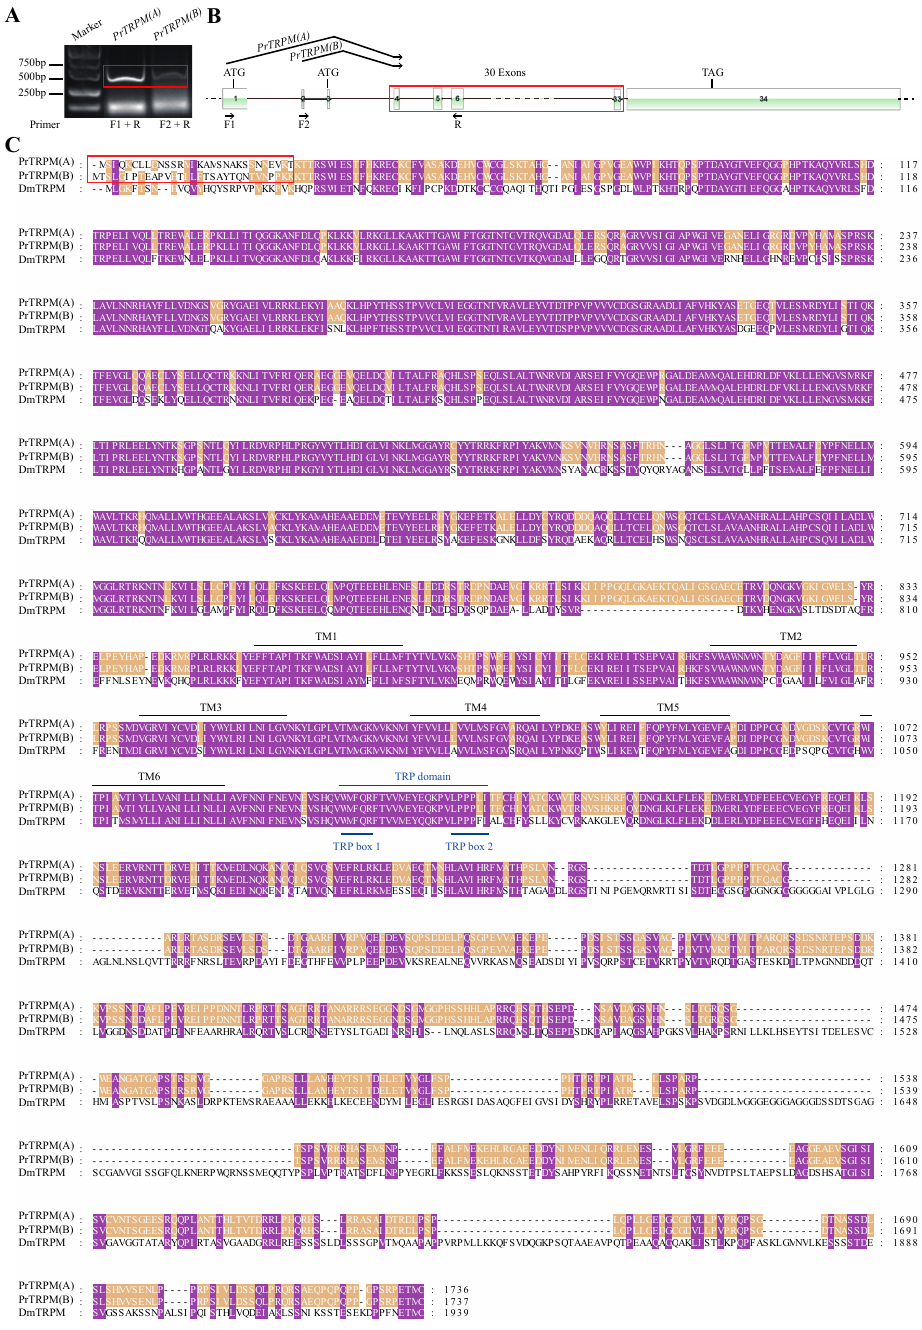
Figure 4. Detection and amino acid sequence alignment of the two PrPRPM splice forms. ( A ) Two molecular isoforms of PrTRPM mRNAs identified by PCR. The bands of PrTRPM mRNAs were indicated with open red box, and the bands below it were primer dimers or none-specific bands. ( B ) Two-dimensional gene structure map of PrTRPM . The boxes represented the exons of PrTRPM , the black solid lines connecting the boxes represented the introns and the black dotted lines on both sides represent other genome sequences. ( C ) Multiple sequence alignment deduced for PrTRPM(A), PrTRPM(B) and DmTRPM. The red box indicates the different amino acid residues of the two isoforms. TRP boxes and TRP domain were indicated with blue lines. Ankyrin repeats were indicated with dotted lines and marked as ANK1–2. Transmembrane regions were indicated with solid lines and marked as TM1–6. The protein sequences used for multiple sequence alignment were in the attached fasta